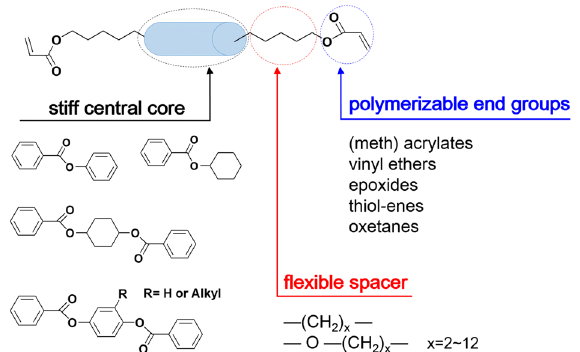
Figure 5. Schematic illustration of the formation of the LC monomer.